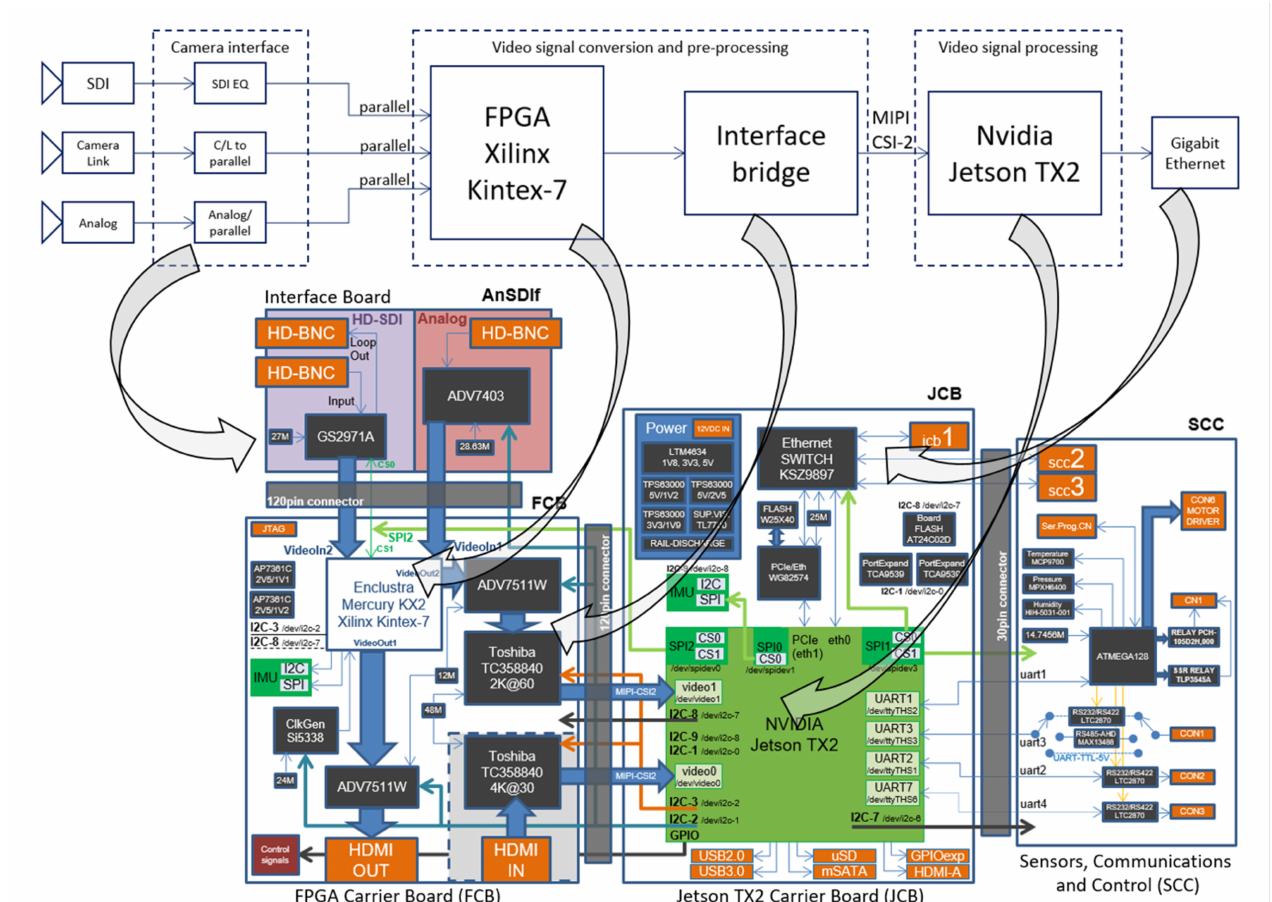
Figure 3. Video signal path ( top ) and VVSP module architecture ( bottom